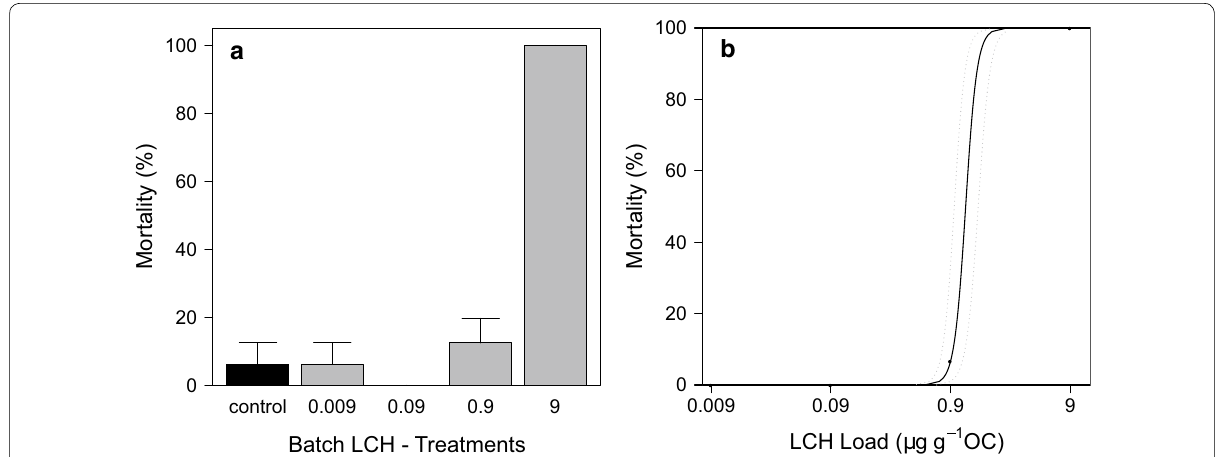
SE, n 4] and b Concentration response relationship calculated using ± =